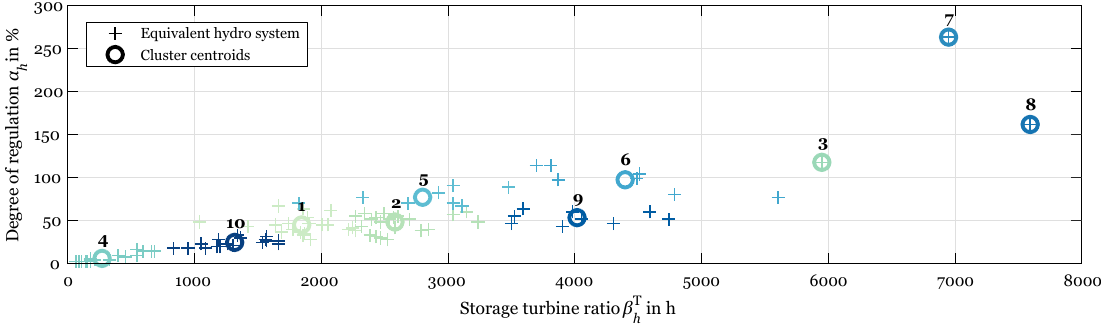
Figure 6. Clustering results for the basic clustering category in market area